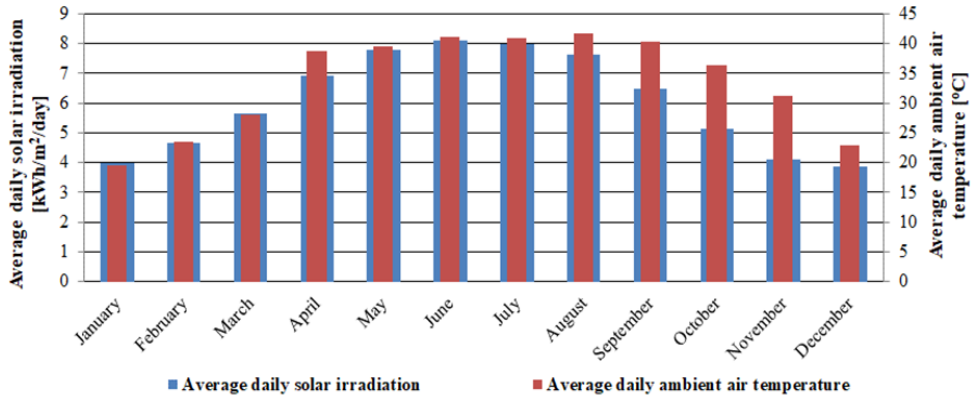
Figure 4. Average daily solar irradiation and daily ambient temperature of the city of Aswan, Egypt (22°25′ N 31°45′ E).